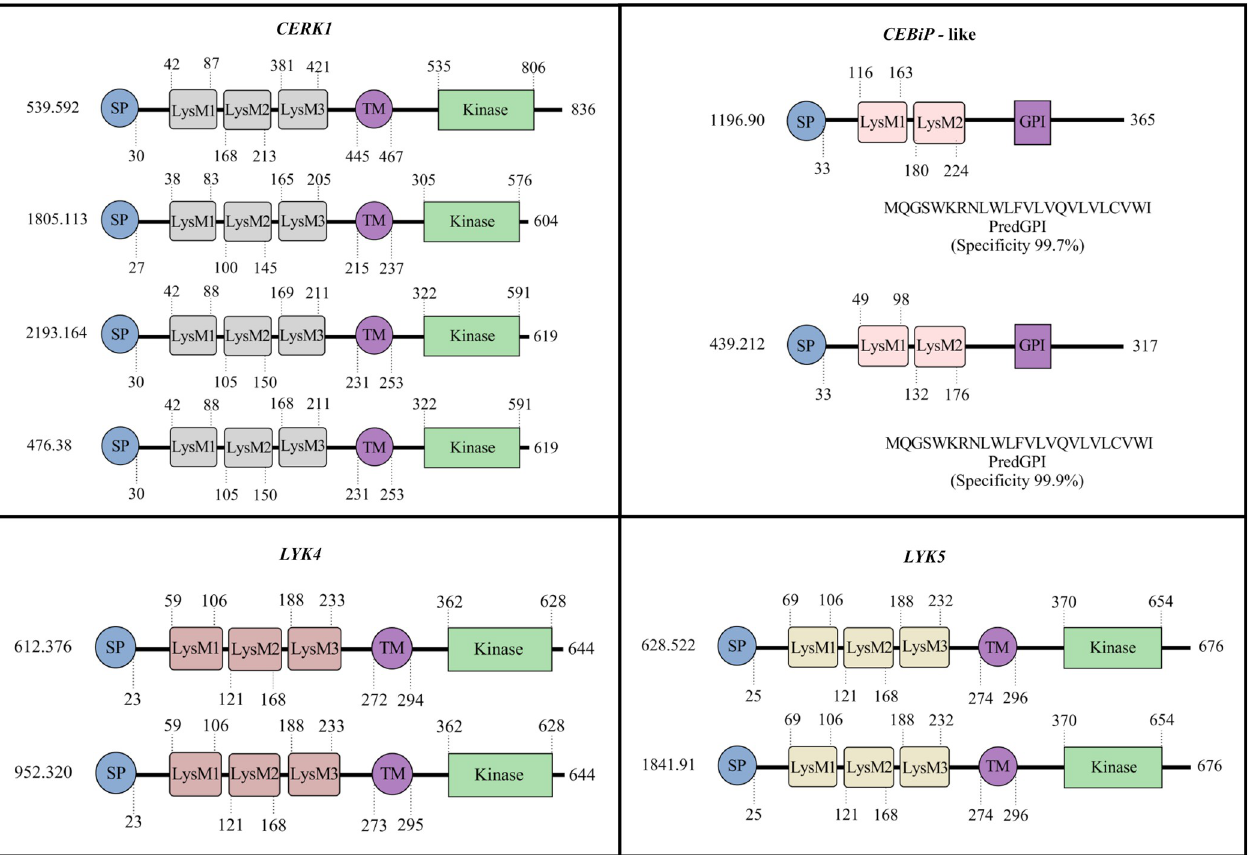
Fig 2. Protein characterization of the candidate sequences for CERK1 , LYK4 , LYK5 , and CEBiP -like in C . arabica . The signal peptide positions, lysin motifs (LysM) and transmembrane domains were identified by SMART, and the GPI anchor by PredGPI. The domains positions are represented by numbers at the beginning and end of each domain. Concerning the CEBiP -like candidate sequences, the putative signal sequences for the GPI anchor and their specificities are shown. The numbers at the beginning of each sequence represents the scaffold (candidate sequence in C . arabica ). The numbers at the end of each sequence represents the size of the proteins in number of amino acids. SP: signal peptide, LysM: lysin motifs identified as 1,2 e 3, TM: transmembrane domain, GPI: GPI-anchor.